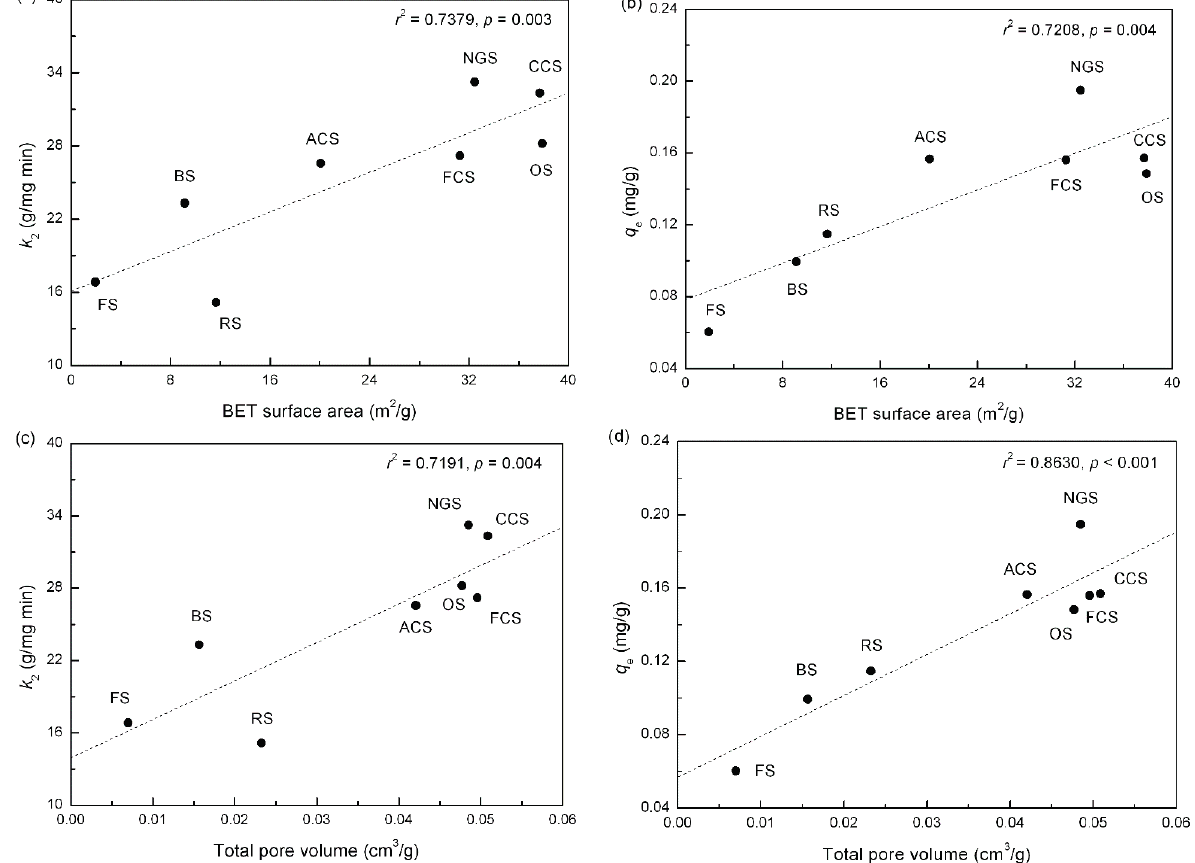
Figure 4. Variation of the non-linear pseudo-second-order kinetic constants as a